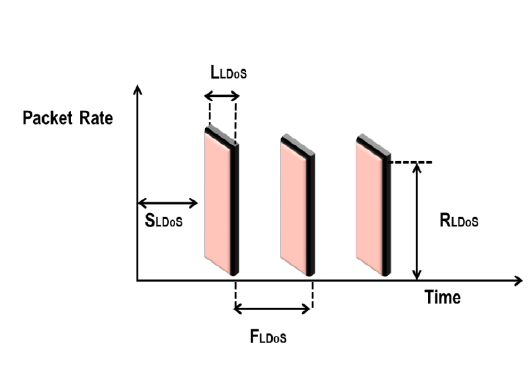
Fig. 1. Representation of